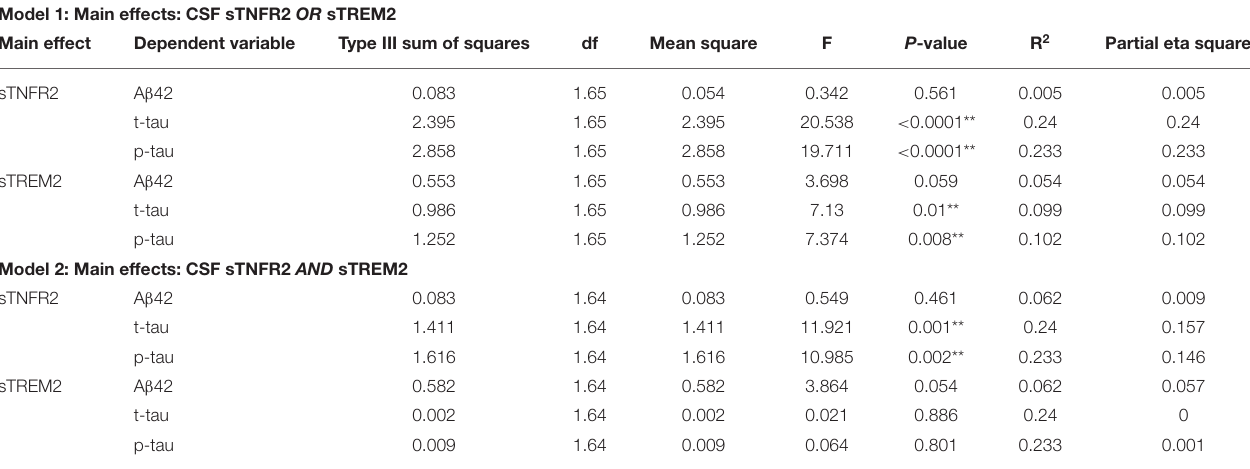
TABLE 3 | Key results of the general linear model with CSF A β 42, t-tau, and p-tau as the dependent variables and covariates: age, sex, education, APOE ε 4 status, among participants from the Alzheimer’s Disease Neuroimaging Initiative cohort with mild cognitive impairment (participants meeting A + T + criteria). Model 1: Main effects: CSF sTNFR2 OR sTREM2